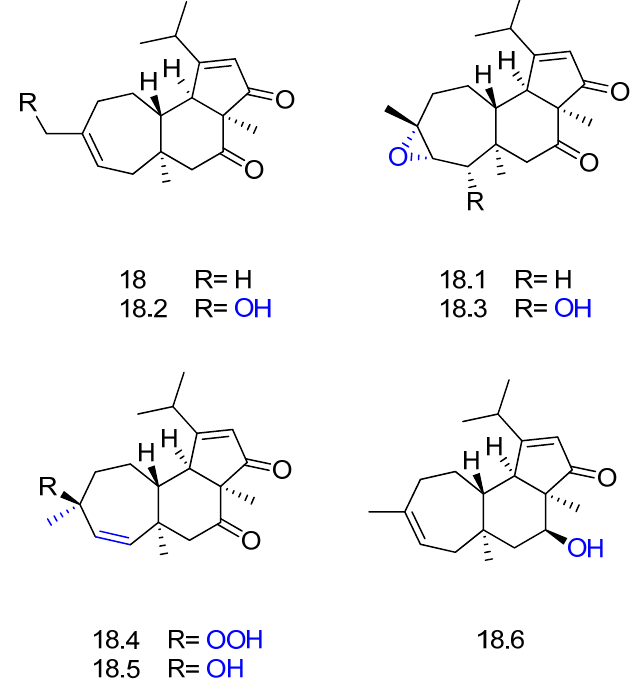
Figure 19. Structures of cyanthwigin B ( 18 ) and its derivatives 18.1 – 18.6 obtained by biotransformation with actinomycete Streptomyces sp. [67] .